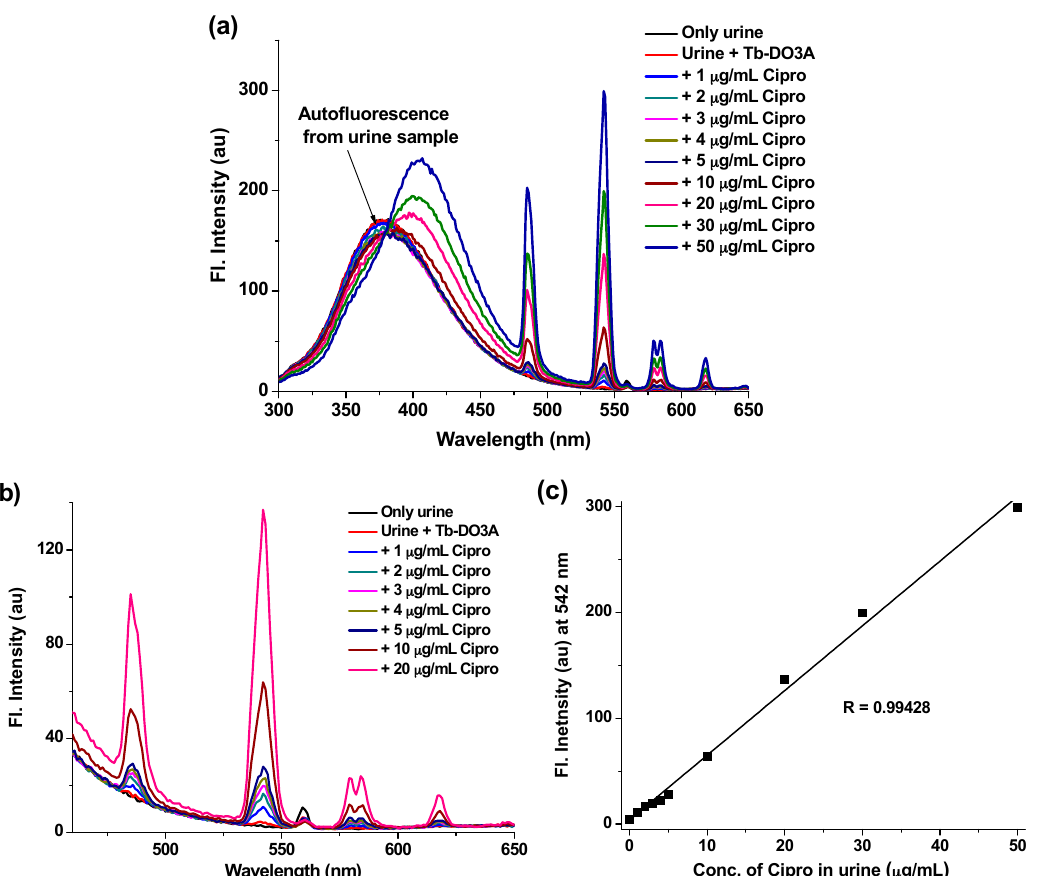
Figure 6. ( a ) Full emission spectra of urine, urine treated with Tb-DO3A, and urine treated both with Tb-DO3A and varying concentration of Cipro. The raw urine was diluted 10-times with DI-water. Tb-DO3A was added at a fixed concentration of 20 µ M. The Cipro was added at various concentrations ranging from 1 µ g · mL − 1 to 50 µ g · mL − 1 with respect to the actual raw urine sample. The spectra were recorded after excitation at 278 nm. ( b ) The terbium emissions observed at the lower Cipro concentration region, which was produced from (a). ( c ) The linear intensity changes of terbium emission at 542 nm with increasing concentrations of Cipro, as measured in urine sample.